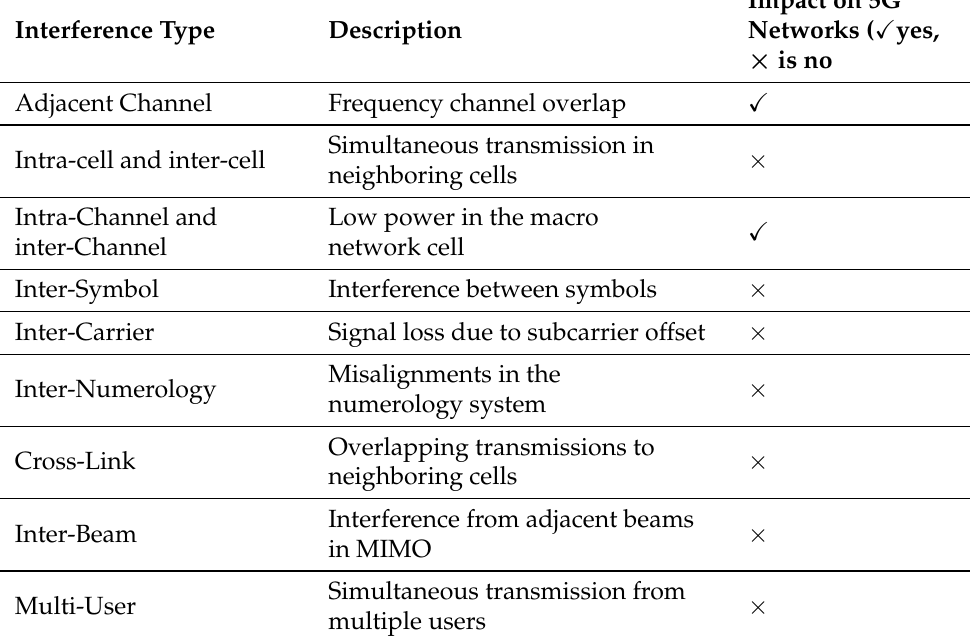
Table 9. Interference and its impact on 5G